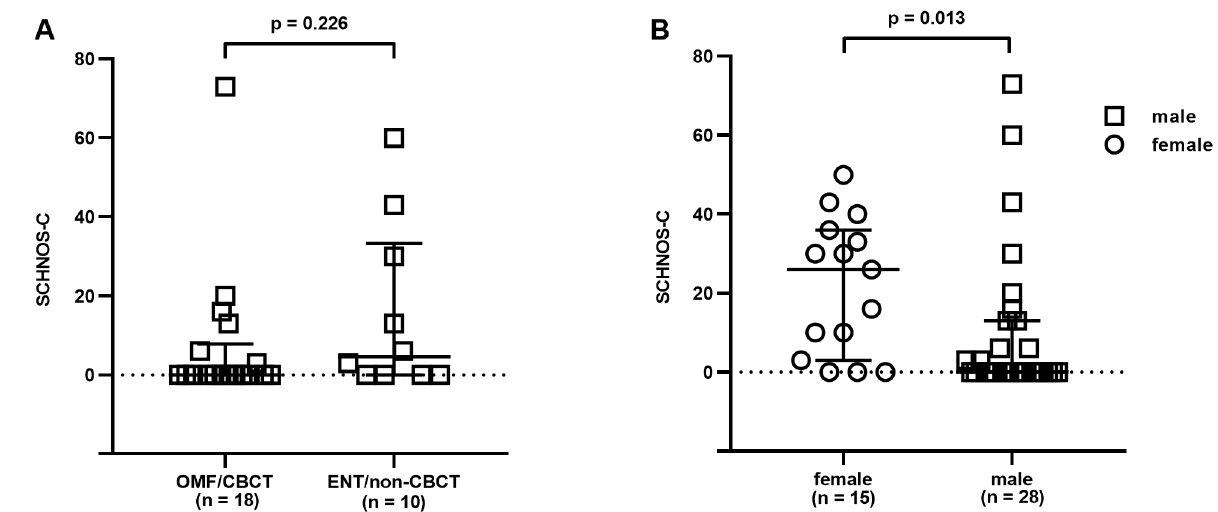
Figure 4. Comparison of SCHNOS-C between male patients of the two groups (A) and between male and female patients of both groups (B).